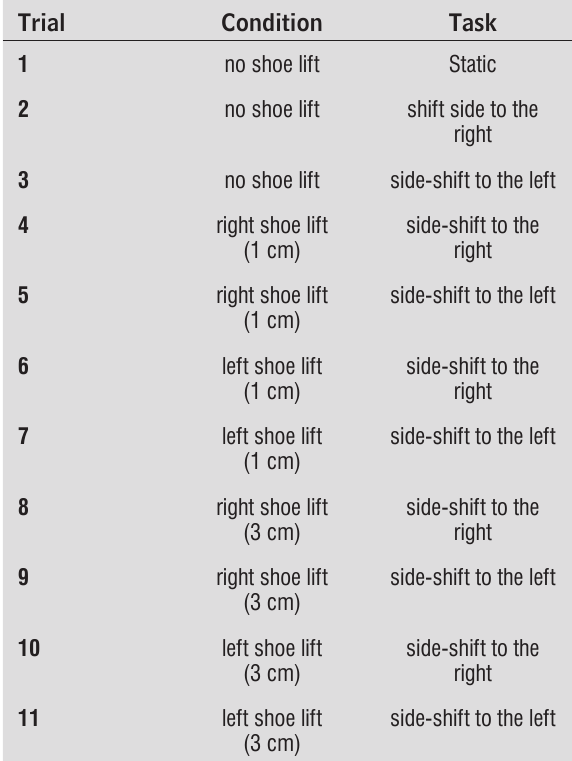
Table 1 - Collection steps divided into trials, conditions and tasks performed by the control and